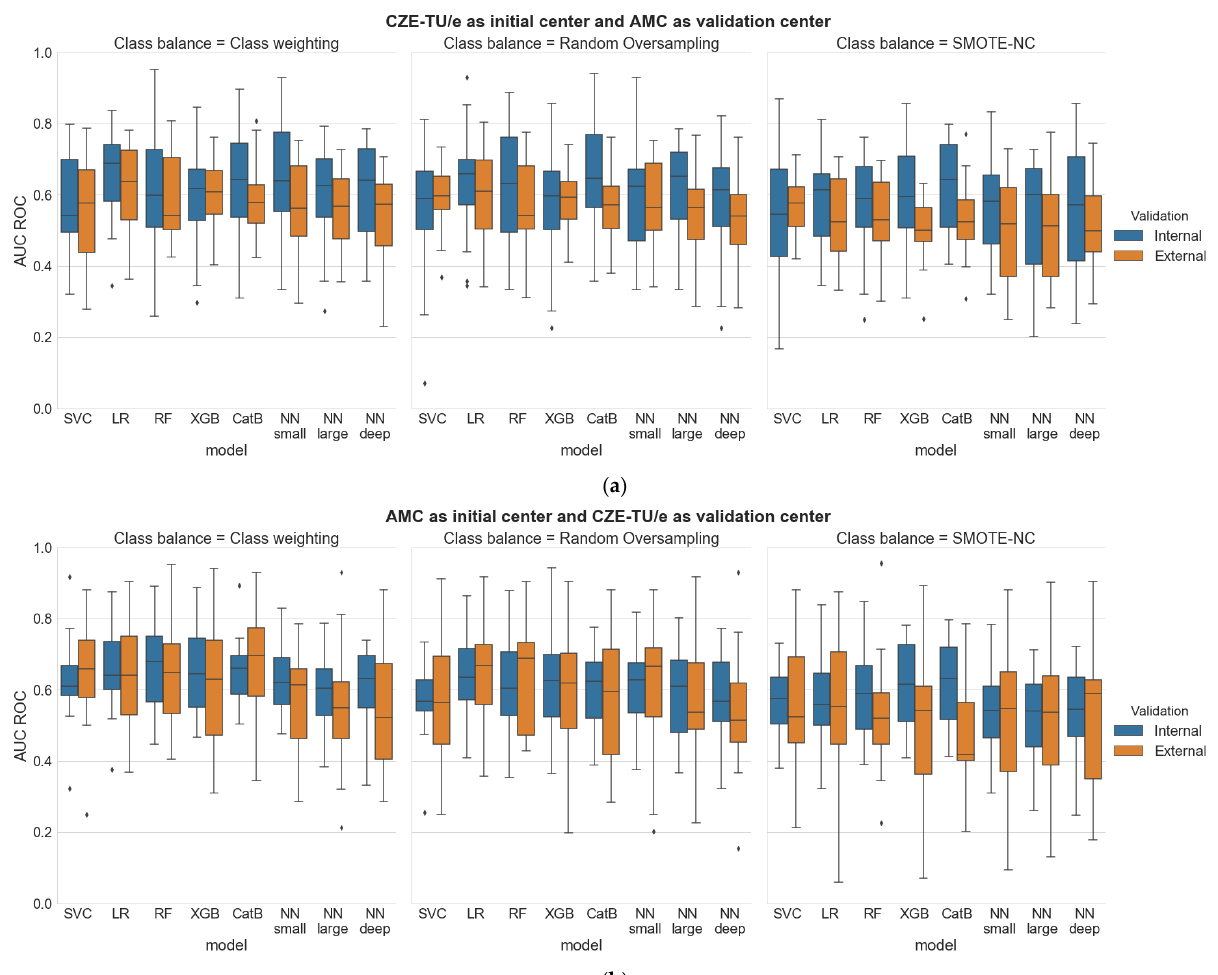
Figure 5. Area under curve (AUC) of the receiver operating characteristic (ROC) for the top-three classifiers per center with the highest validation score are shown with different colors. Both centers internal validation ( a ) and external valida- tion ( b ) AUC metrics are shown jointly in this figure to highlight the similarity.